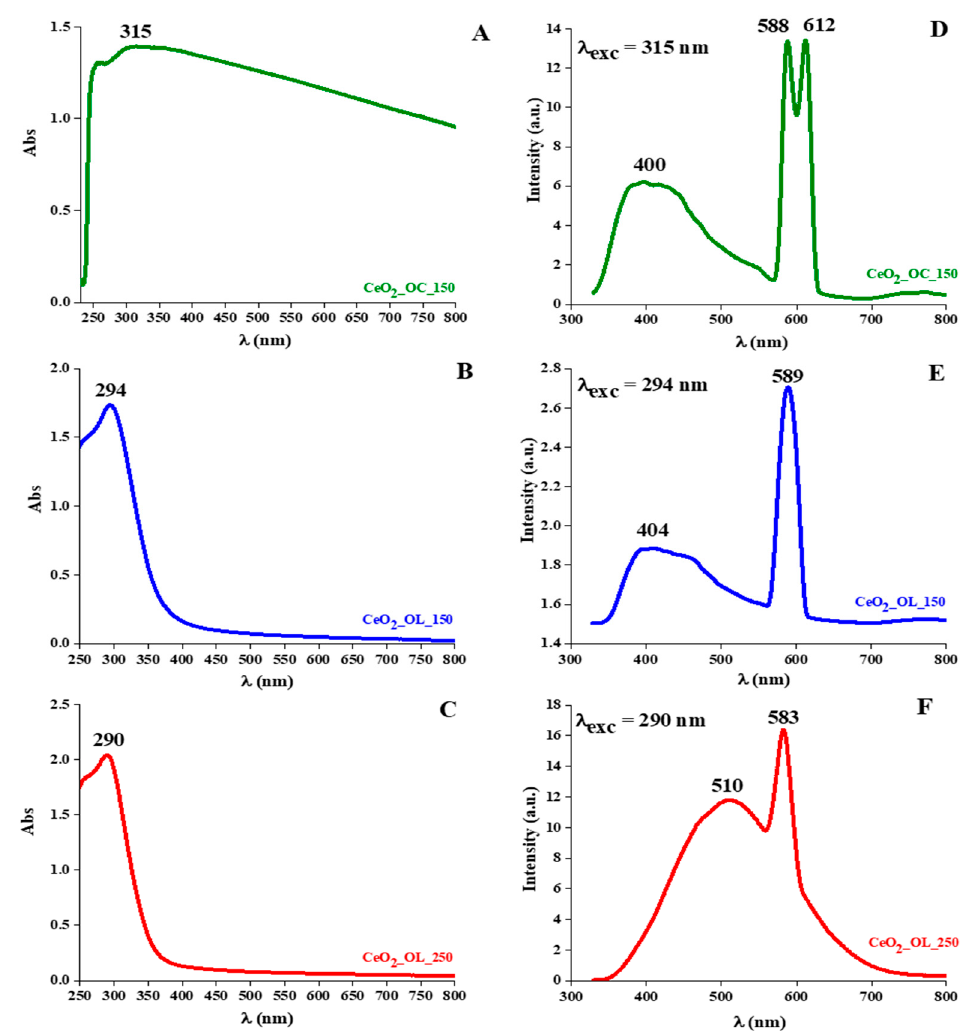
Figure 6. ( A ) UV-Visible spectra of CeO 2 _OC_150 (green line), ( B ) CeO 2 _OL_150 (blue line) and ( C ) CeO 2 _OL_250 (red line); ( D ) Fluorescence spectra of CeO 2 _OC_150 (green line), ( E ) CeO 2 _OL_150 (blue line) and ( F ) CeO 2 _OL_250 (red line).